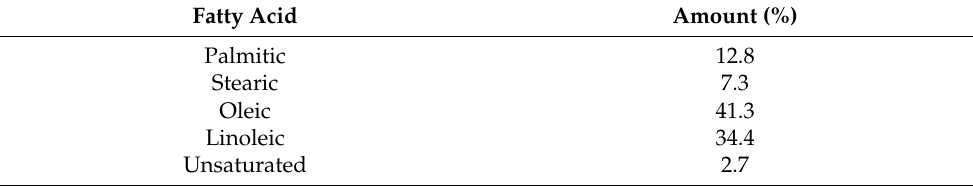
Table 1. Fatty acid components in jatropha